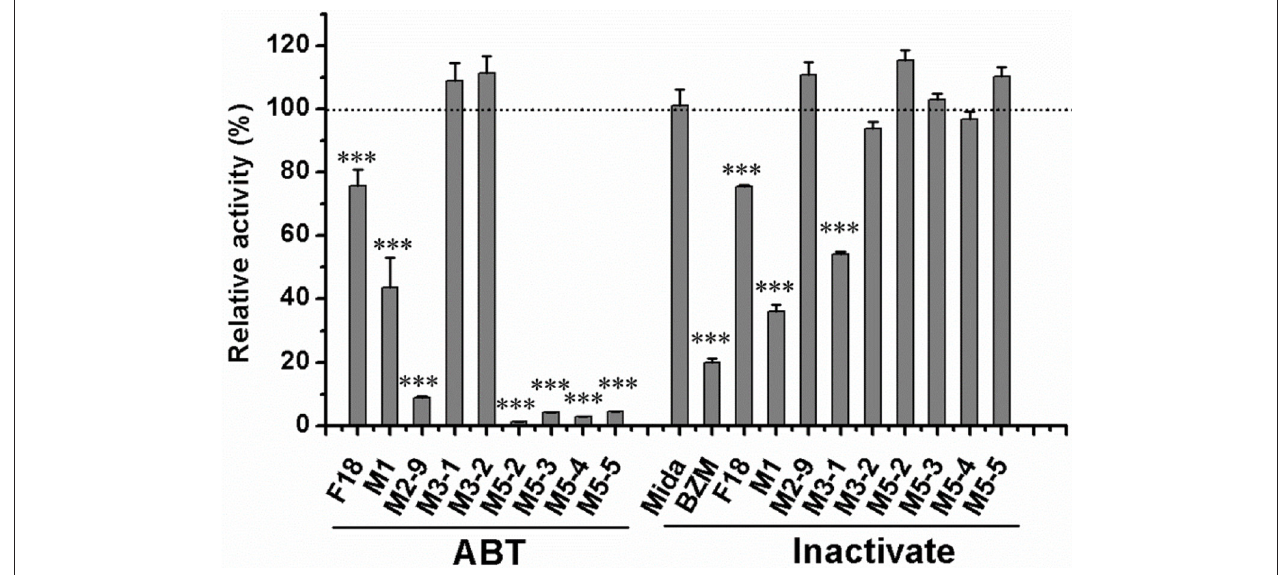
FIGURE 4 | Effects of ABT and thermal inactivation on the metabolism of F18 in human liver microsomes. F18 (10 µ M) was incubated with HLMs in the absence or presence of aminobenzotriazole for 30 min. For thermal inactivation studies, HLMs (0.5mg protein/mL) were preincubated at 50 ◦ C for 5 min and then incubated with F18 (10 µ M) for 10 min. The data are expressed as percentages of the control and represent the means ± SD from three independent experiments. BZM, Benzydamine; Mida, midazolam; ABT, aminobenzotriazole. Statistical significance was assessed using one-tailed student’s t -test and is indicated with *** p < 0.005.